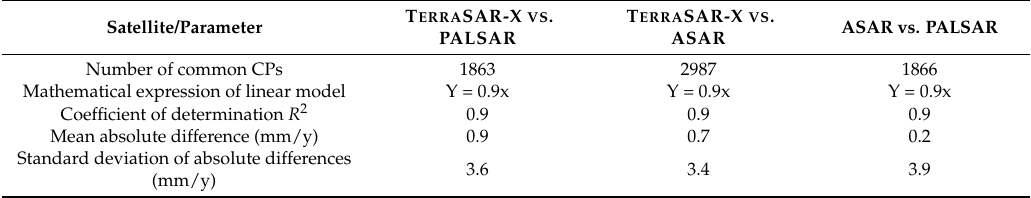
Table 2. Results of cross validation among the three SAR data stacks.